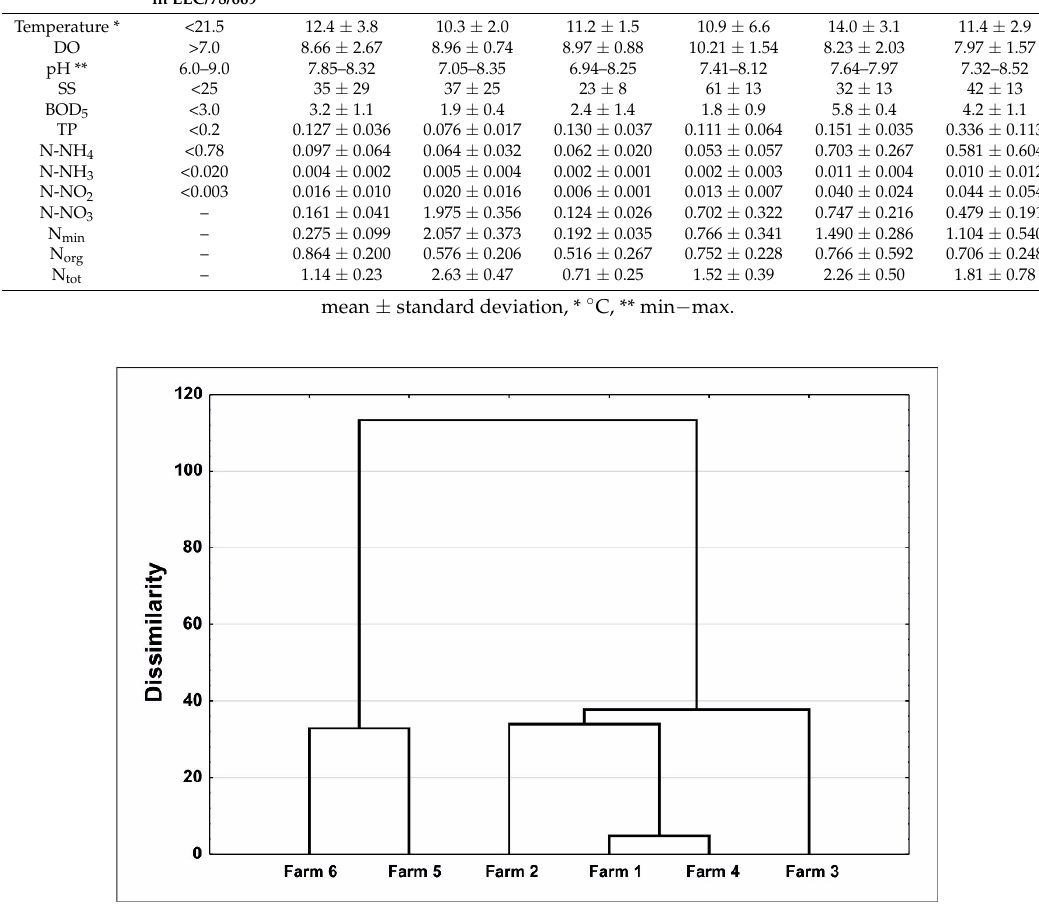
Figure 6. Grouping of waters outflowing from the fish ponds with the Ward method.